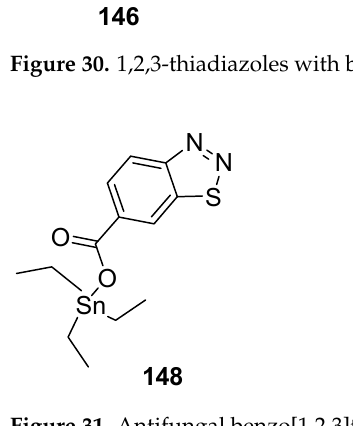
( Figure 32) displayed